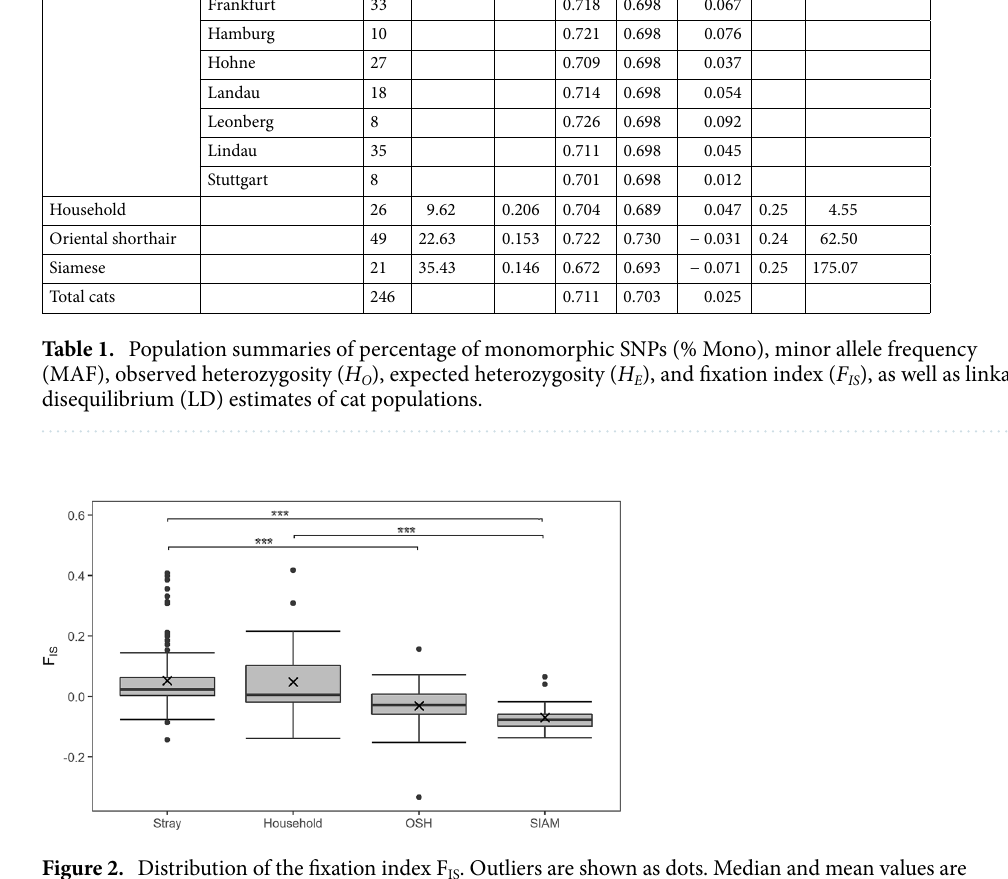
Figure 2. Distribution of the fixation index F IS . Outliers are shown as dots. Median and mean values are indicated with a thick horizontal line and a cross. ***p <